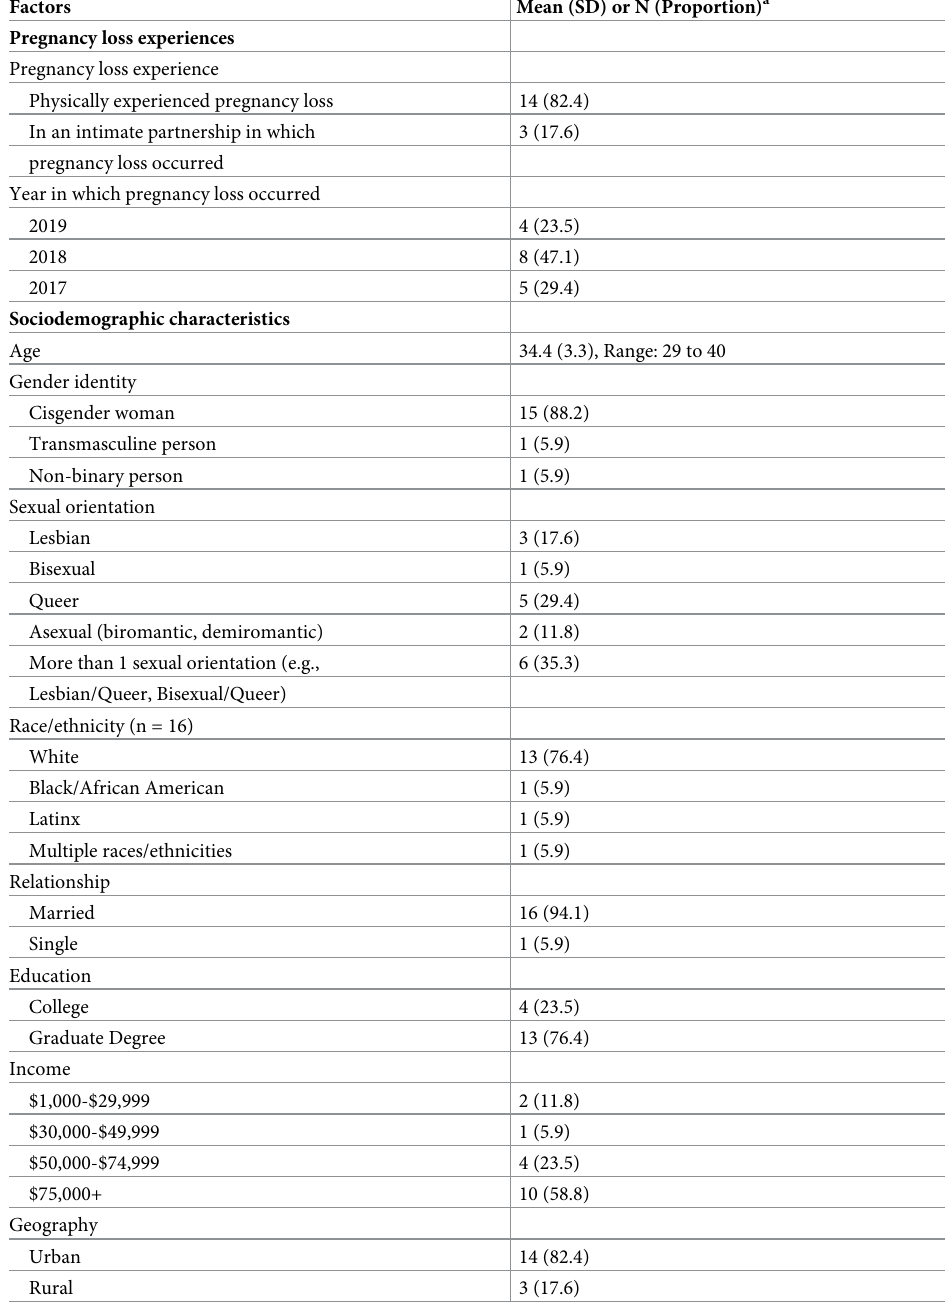
Table 1. Participant